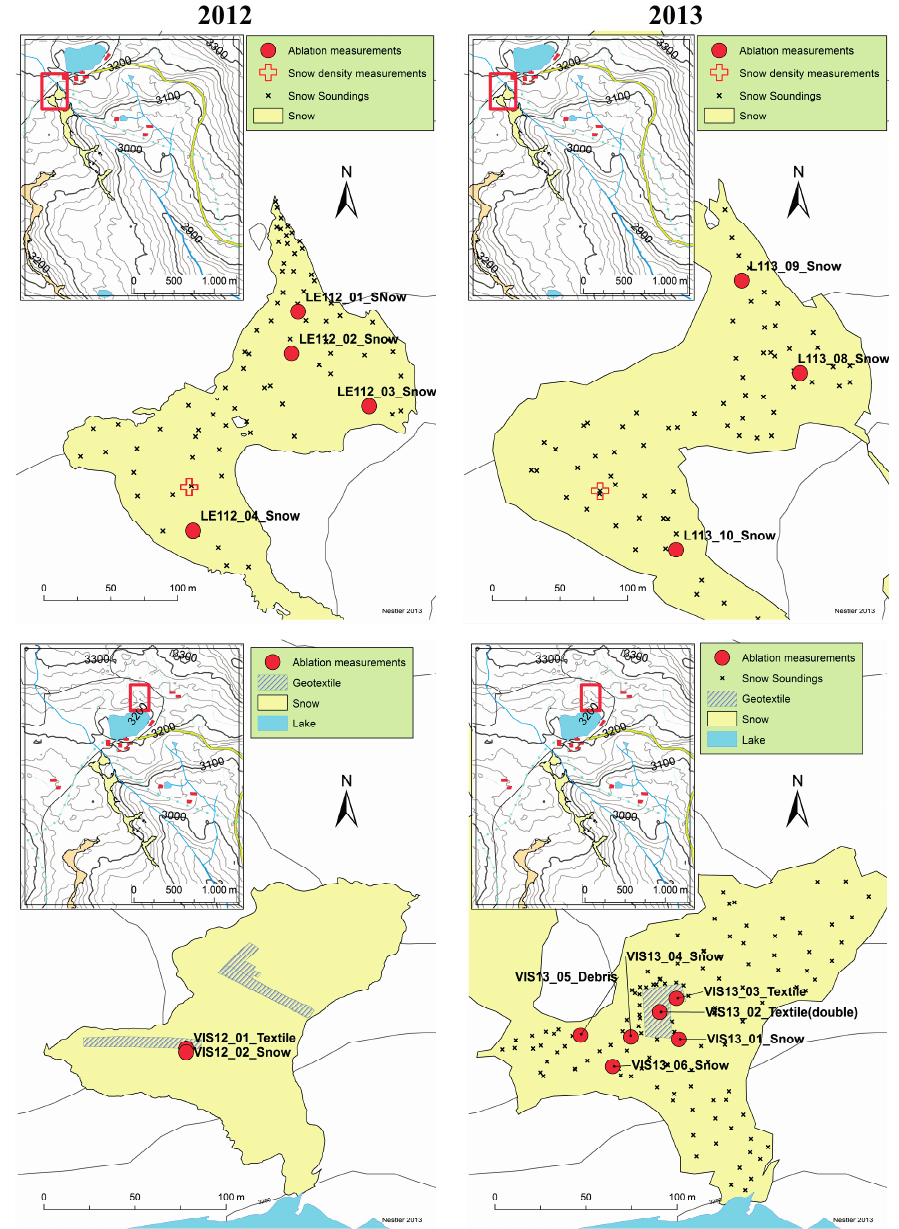
Figure 4. An overview of glaciological measurements on two snow fields in 2012 and 2013 (see Figure 2 and the red square in the overview map for the location). Ablation measurements, snow soundings, density measurements and the areas covered